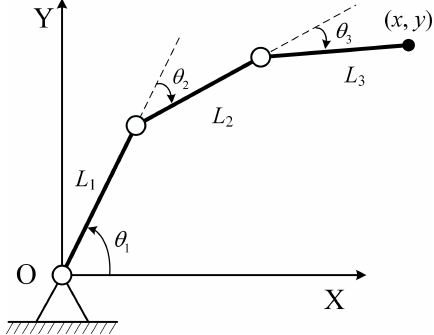
Figure 4. The schematic diagram of a planar